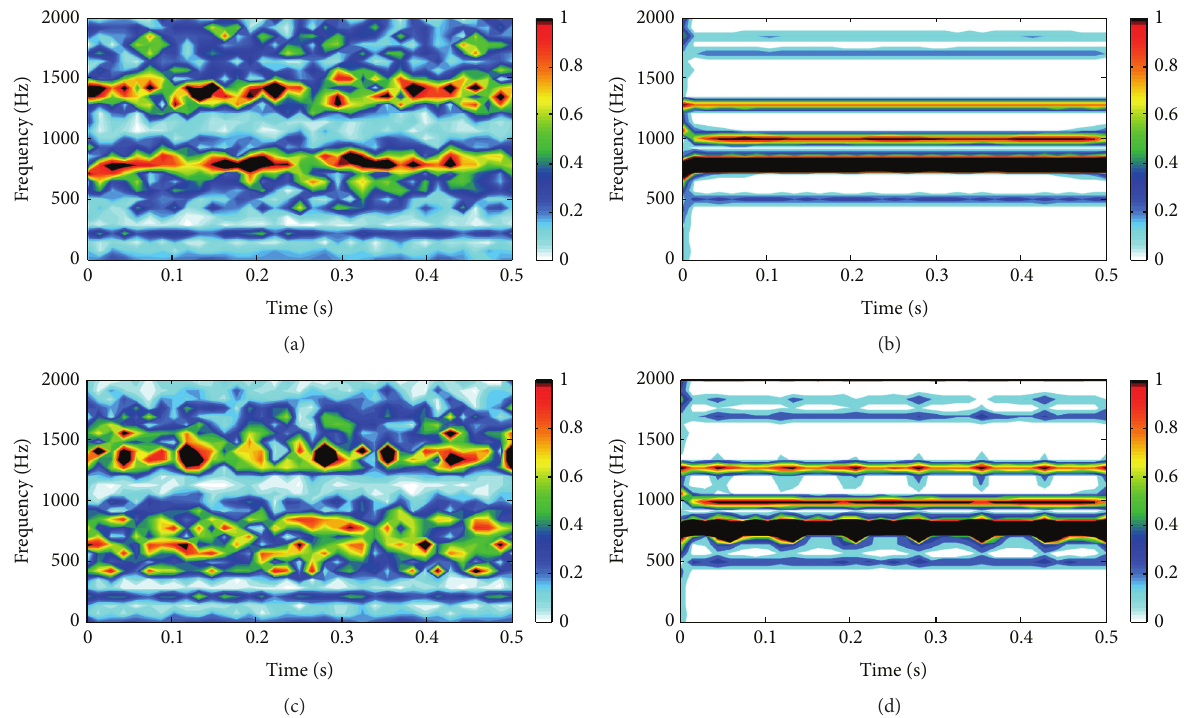
Figure 9: HWT of experimental data and model results for 820 rpm constant speed test: (a) healthy data, (b) healthy model, (c) damaged (missing tooth) data, and (d) damaged model.